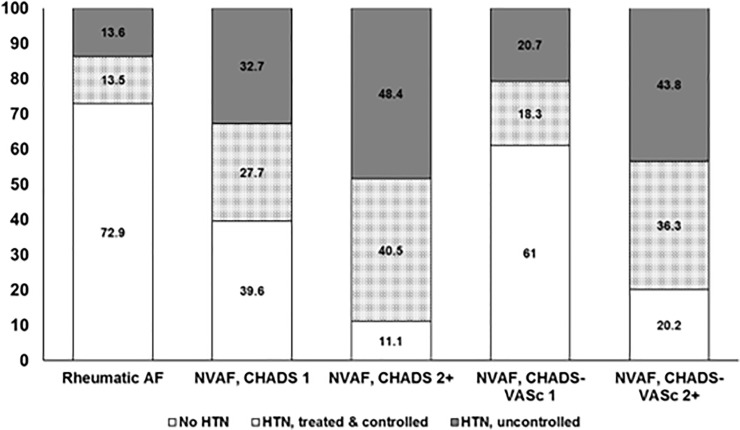
Hypertension prevalence, treatment, and control in RE-LY participants, stratified by CHADS2 and CHA2DS2-VASc scores.